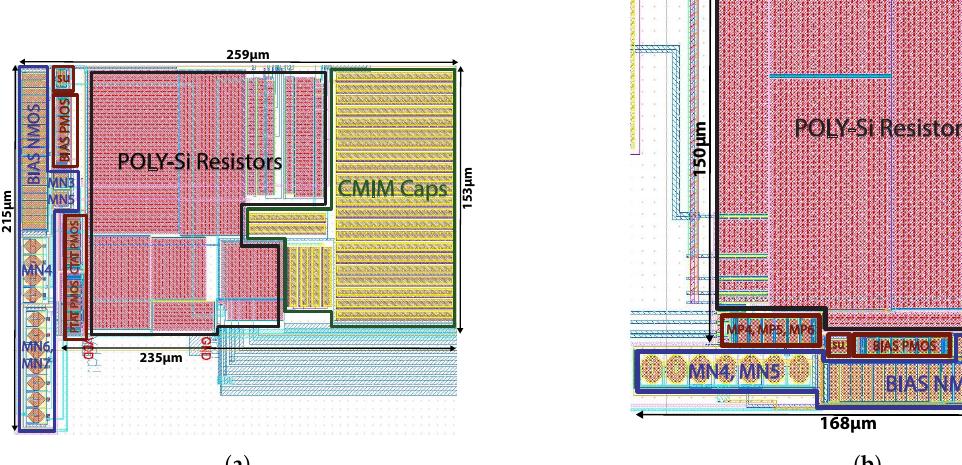
Figure 2. Layout of the proposed voltage references. ( a ) Layout of VR1 [51]; ( b ) Layout of VR2 [17].